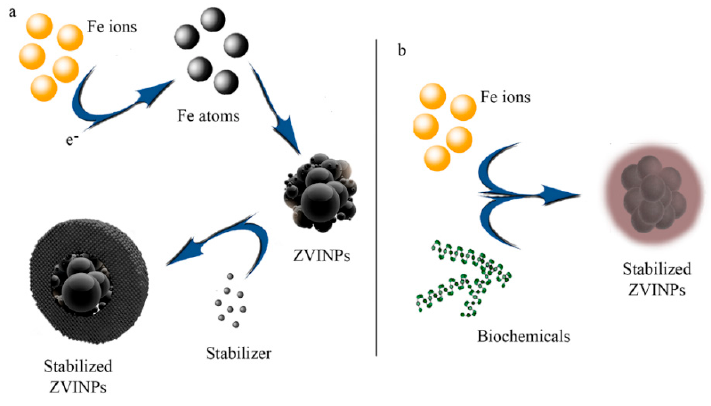
Figure 2. Chemical ( a ) and biological ( b ) reduction of iron ions to zero-valent iron nanoparticles (ZVINPs) and their stabilization.